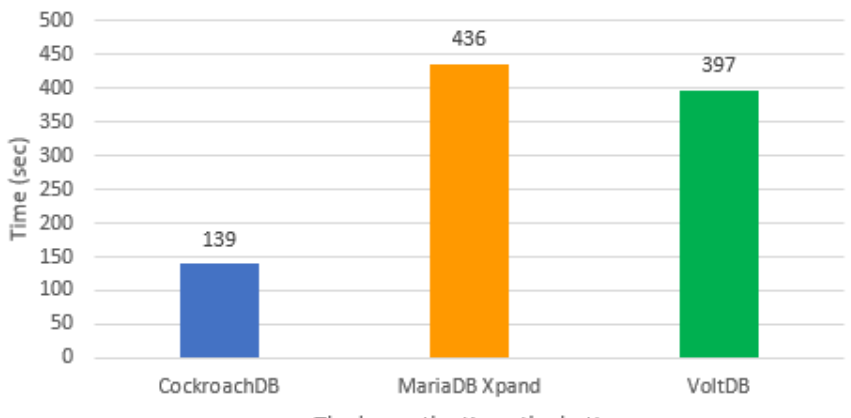
Figure 16. SSB total loading times with SF = 1 and SF = 10.